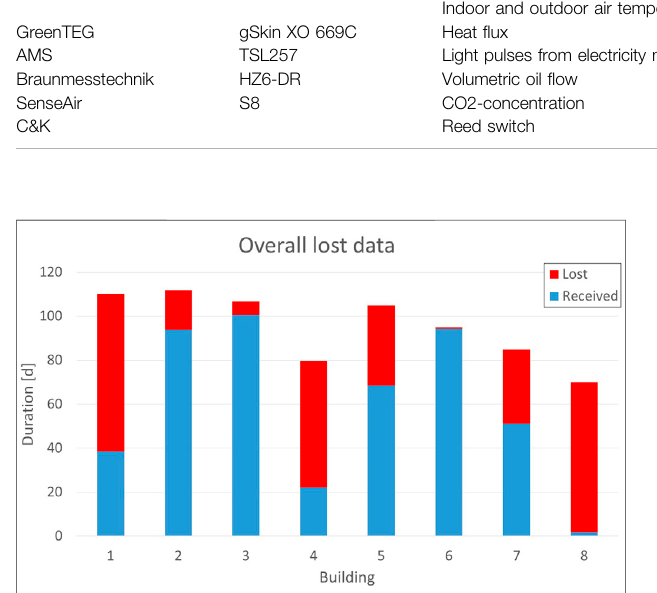
FIGURE 3 | Lost and received data of the longest continuous dataset in days for each